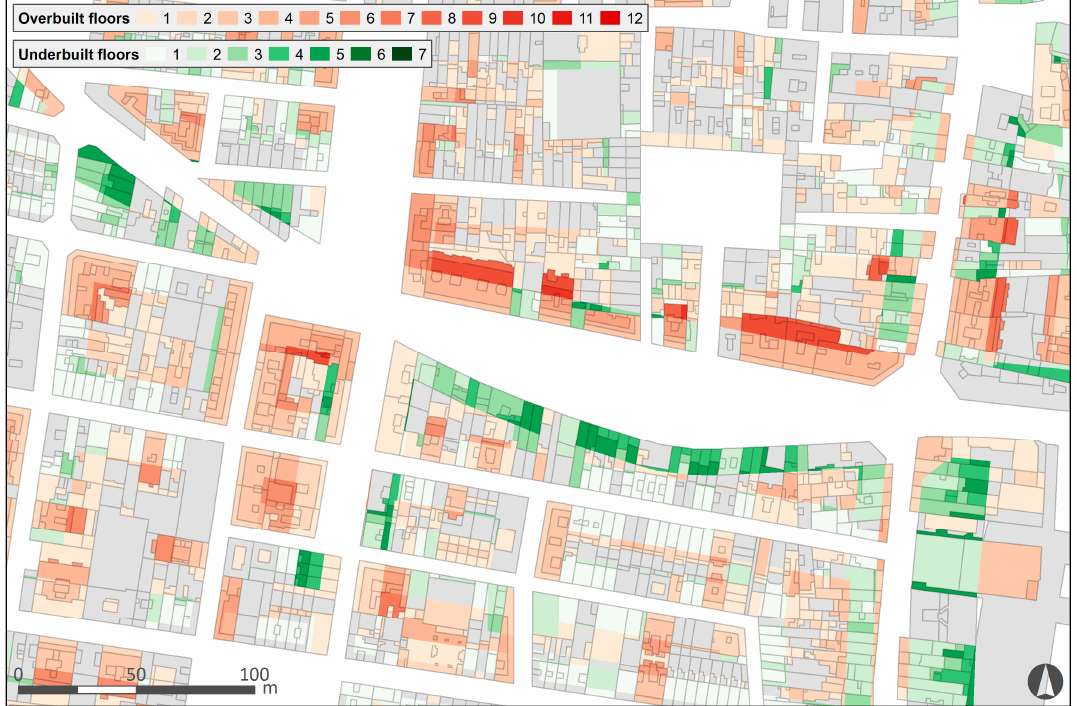
Figure 12. Partial map of underbuilt and overbuilt